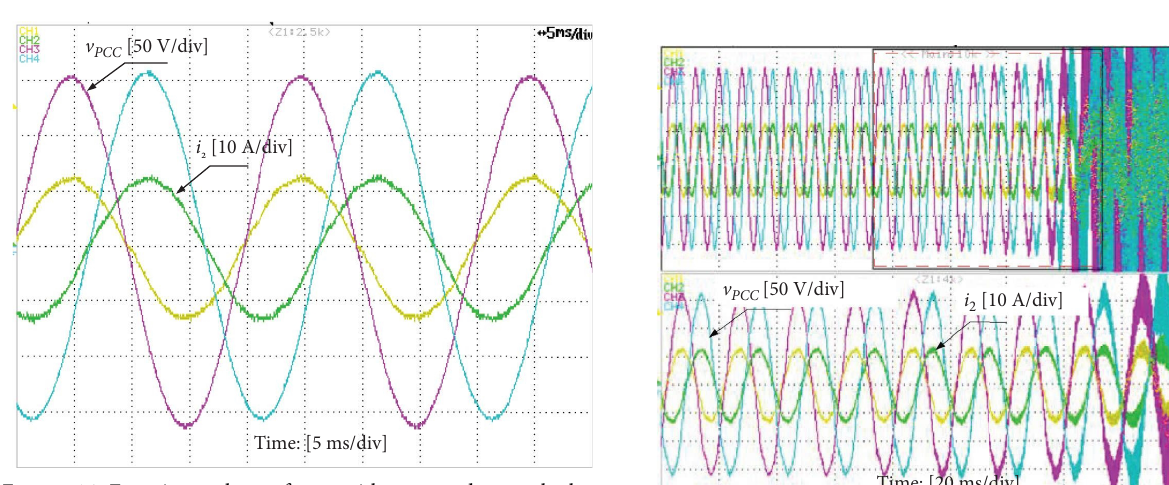
Figure 14: Experimental waveforms with proposed control when L � 3.6 mH and C � 2 μ g g